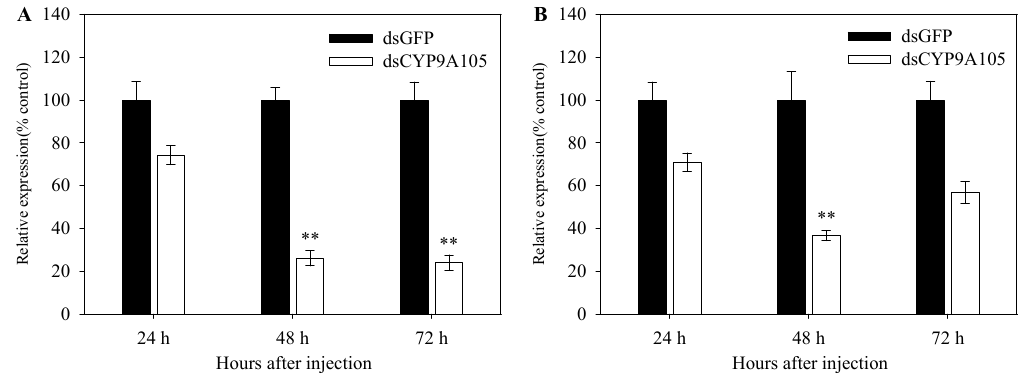
Figure 4. Spodoptera exigua CYP9A105 relative transcript levels in midguts ( A ) and fat bodies ( B ) following injection of dsGFP or dsCYP9A105. Data shown are mean ± SE derived from three biological replicates. Asterisk indicates a significant difference between relative transcript levels of dsGFP injected individuals compared with dsCYP9A105 injected individuals ( p < 0.05, Student’s t -test, ** p < 0.01). Mortality of fifth-instar larvae of S. exigua (without exposure to any insecticide) injected with dsGFP or dsCYP9A105 and then exposed to either α -cypermethrin, deltamethrin, or fenvalerate are shown in Figure 5. This result indicated that delivery of dsCYP9A105 to larvae significantly enhanced